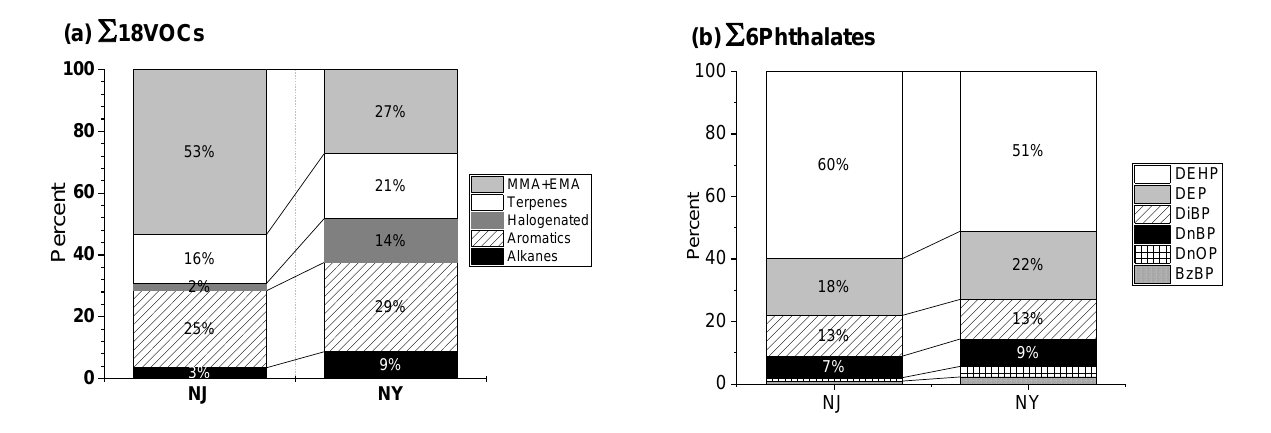
Figure 2. Contribution of categorized sum of 18 VOCs and 6 phthalates in nail salons. ( a ) shows the contribution of five VOC groups to the sum of 18 VOCs: (1) sum of MMA and EMA; (2) terpenes as the sum of α -pinene, β -pinene, and d-limonene; (3) halogenated as the sum of methylene chloride, chloroform, and tetrachloroethylene (TCE); (4) aromatics as the sum of BTEX, styrene, and 1,2,3-trimethylbenzne; and (5) alkanes as the sum of pentane and hexane. ( b ) shows the contribution of individual phthalates the sum of six phthalates. The percentage of both DnOP and BzBP at NJ and NY nail salons were less than 3 percent. Phthalates are Di(2-Ethylhexyl) Phthalate (DEHP); Di-n-octyl phthalate (DnOP); Diisobutyl phthalate (DiBP); Diethyl phthalate (DEP); Di-n-butyl phthalate (DnBP); Benzylbutyl phthalate (BzBP).